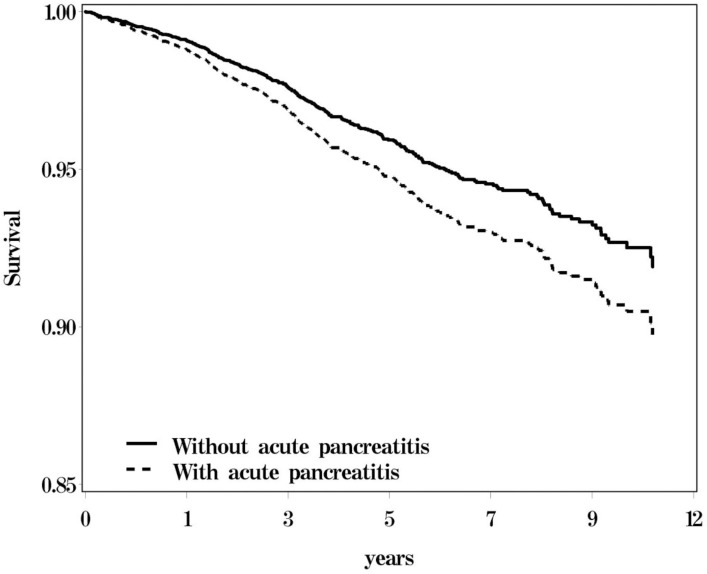
Probability for osteoporosis between subjects with and without acute pancreatitis.